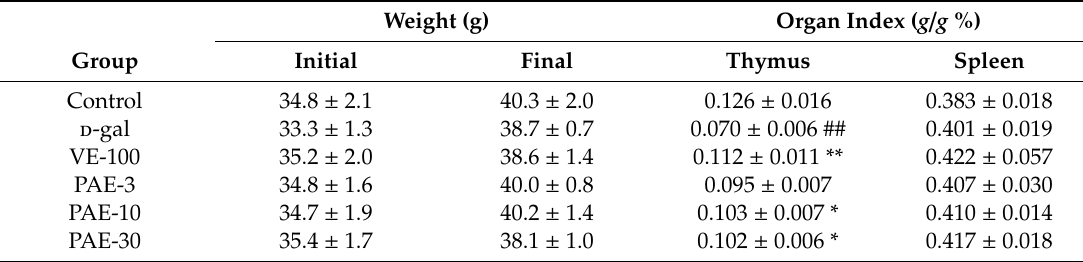
Table 2. E ff ect of PAE on organ index, body